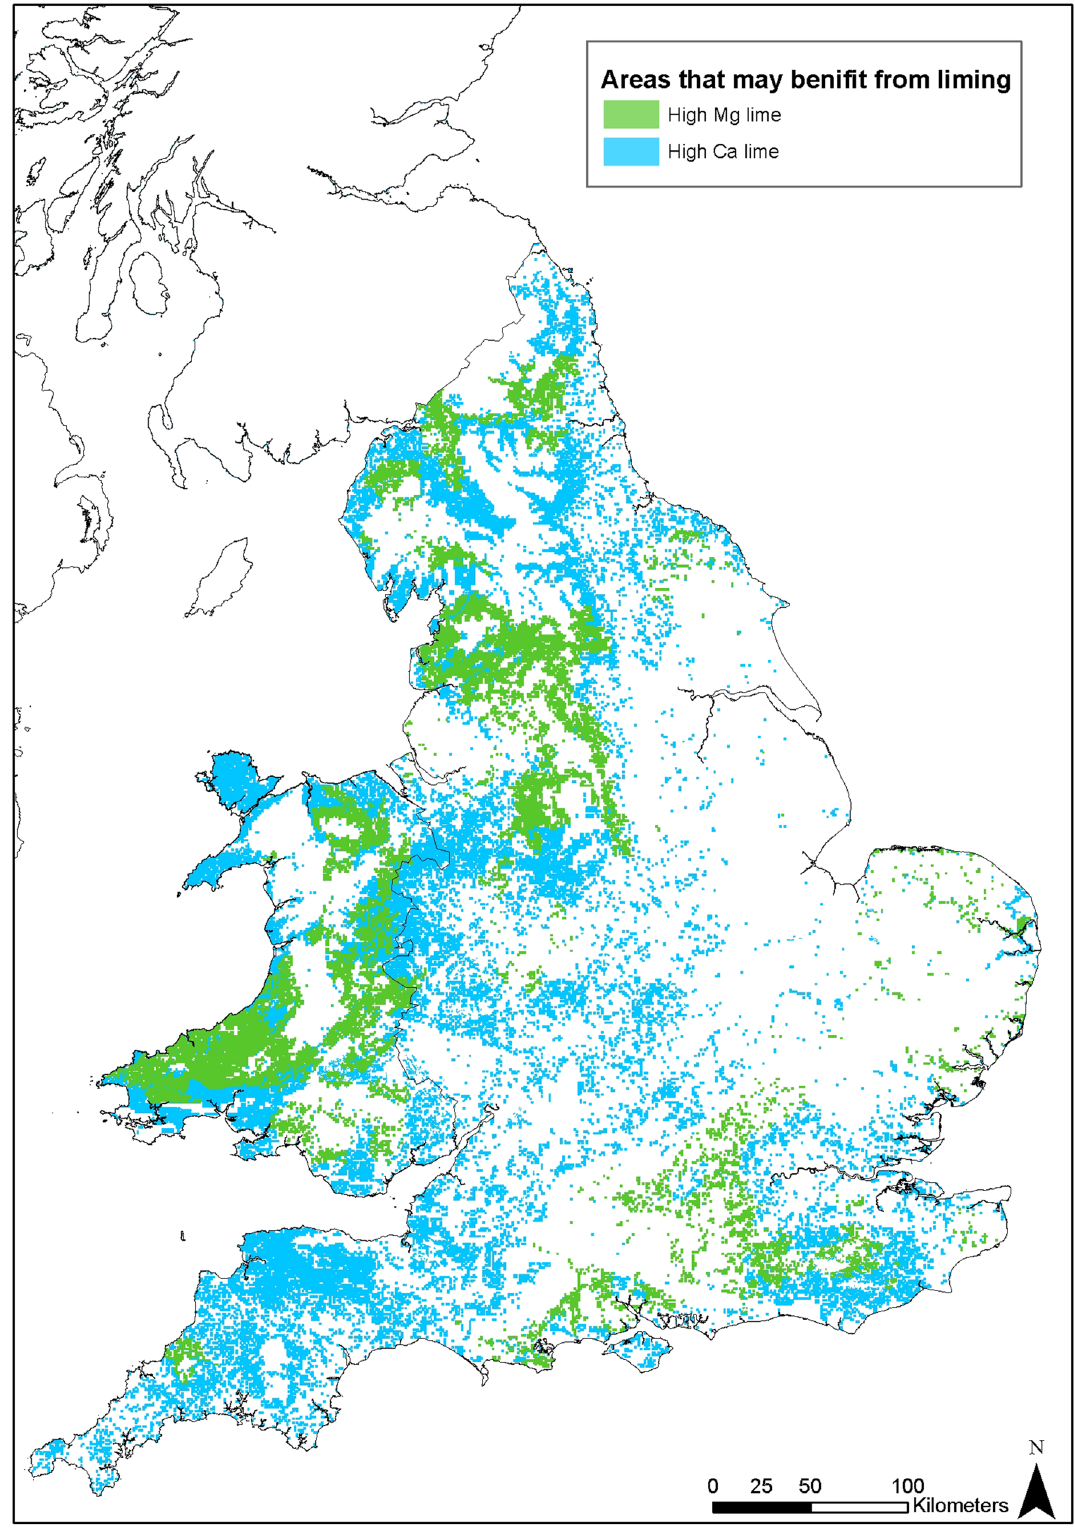
Figure 7. The results of the demand analysis showing areas where the application of agricultural limes may be beneficial. Some features of this map are based on digital spatial data licensed from the UK Centre for Ecology and Hydrology. Created using ArcMap 10.7.1, ESRI,